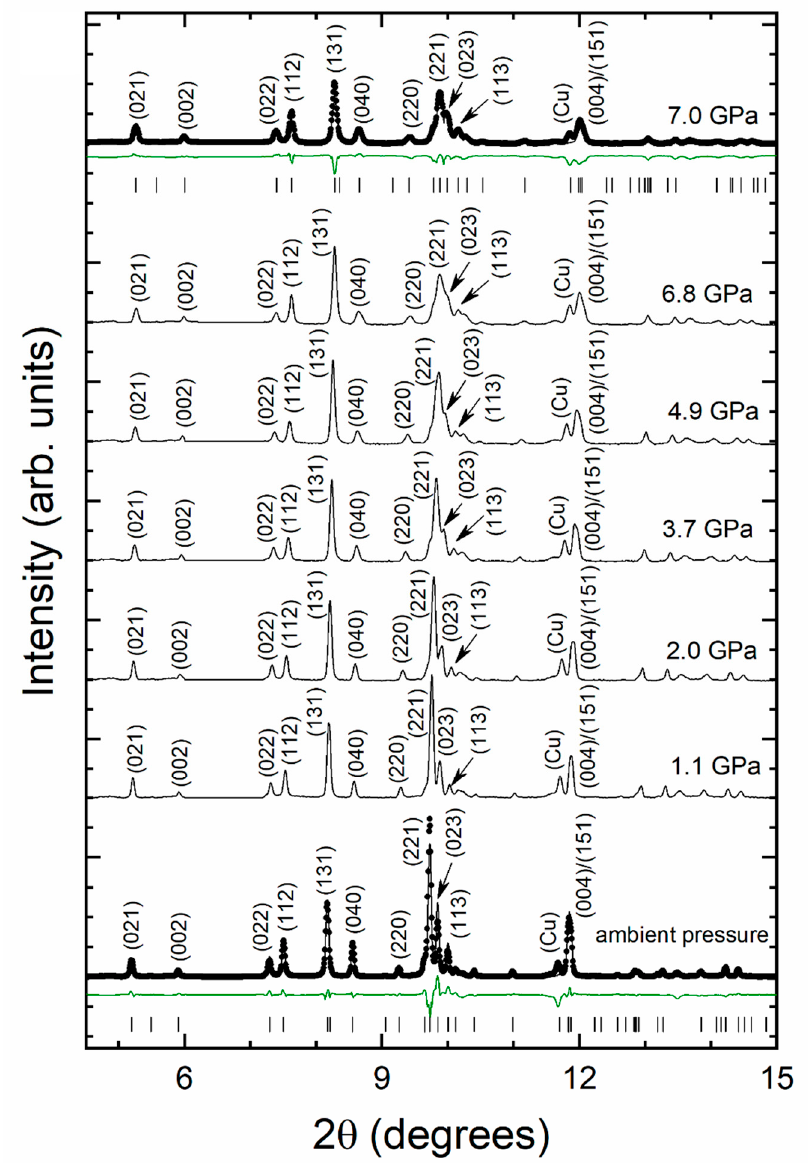
Figure 4. Integrated XRD patterns of Ni 3 V 2 O 8 measured from 0 to 7 GPa. Pressures are indicated on each pattern and Bragg planes corresponding to the most intense reflections have been labeled. At the bottom and top, traces observed experimental data are shown with black symbols. The refinements are shown with black lines. The difference between the observed data and Le Bail refinement is shown in green.